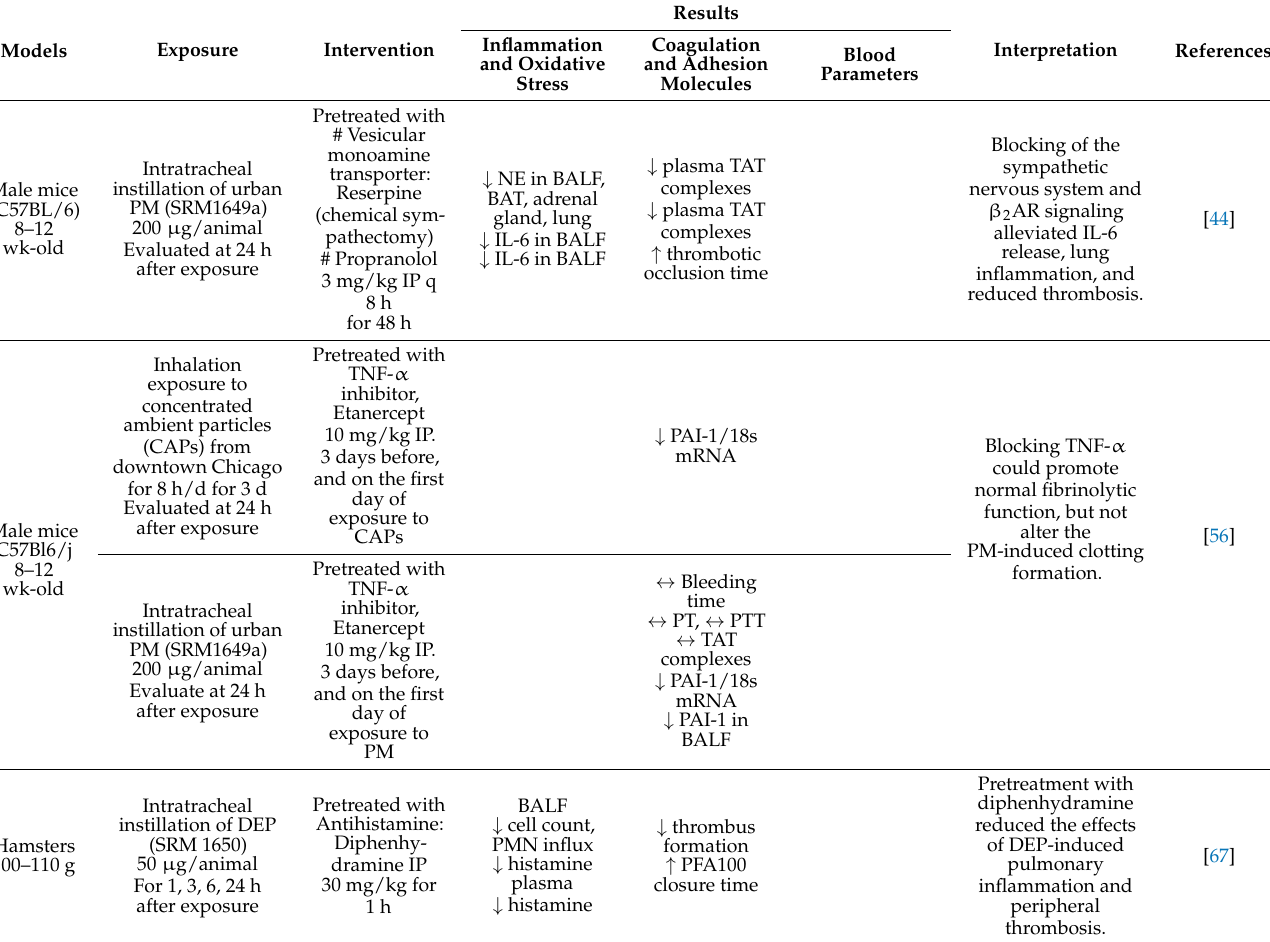
Table 6. The effect of pharmacological interventions on inflammation, oxidative stress, blood pa- rameters, and hemostatic changes under particulate matter condition: Evidence from in vivo and clinical